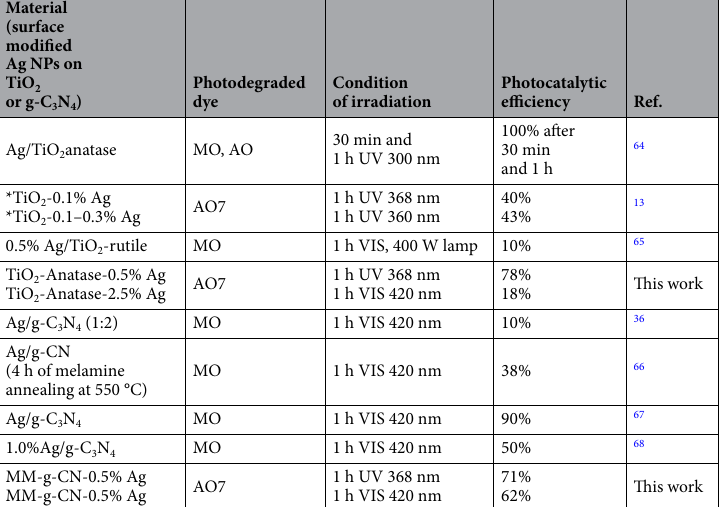
Table 11. Overview of materials used for photodegradation of AO7 or MO or AO. MO, Methyl Orange; AO, Orange P3R Reactive-Orange-12; AO7, Acid Orange 7, *Mixture anatase + rutile.